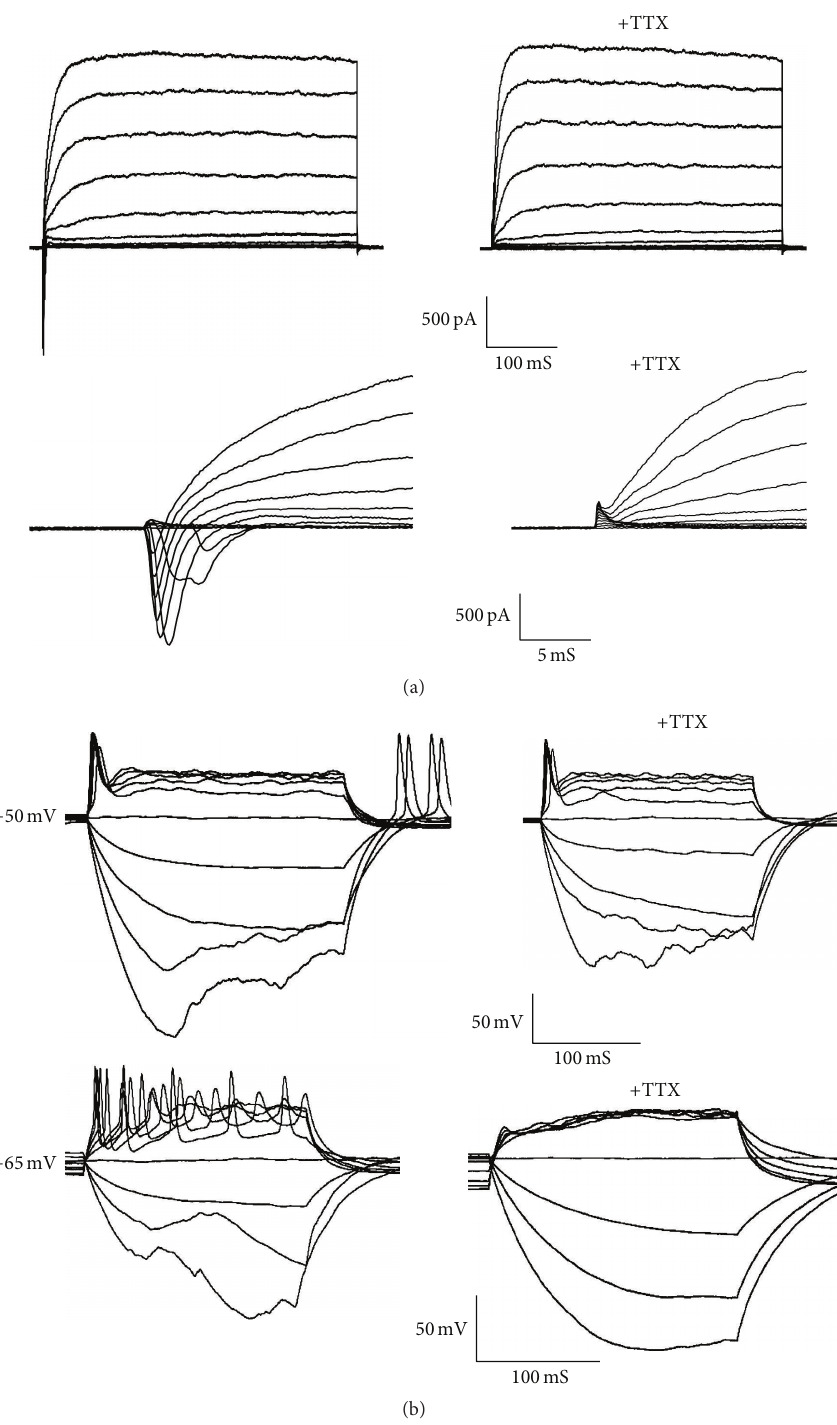
Figure 4: Membrane properties of the urine-iN cells. Whole cell recording was conducted on urine-iN cells identified by differential interference contrast microscopy. (a) Representative traces of membrane currents. Fast-activating and inactivating Na + currents were prominent in all the iN cells. The Na + currents could be blocked by tetrodotoxin (TTX). (b) Representative traces of action potentials in response to step current injections 35 days after induction. Membrane potential was maintained at approximately − 52 mV. And the action potentials could be blocked by TTX